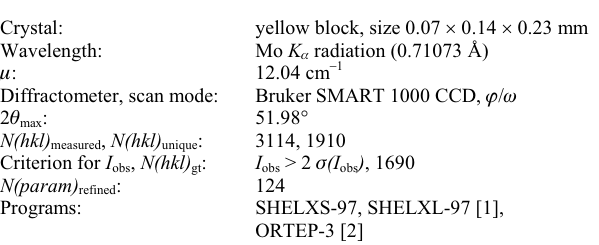
Table 1. Data collection and handling.